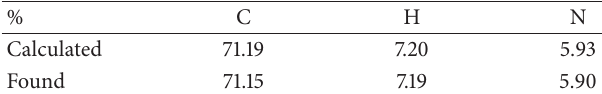
Table 1: Elemental analysis for (EEDB